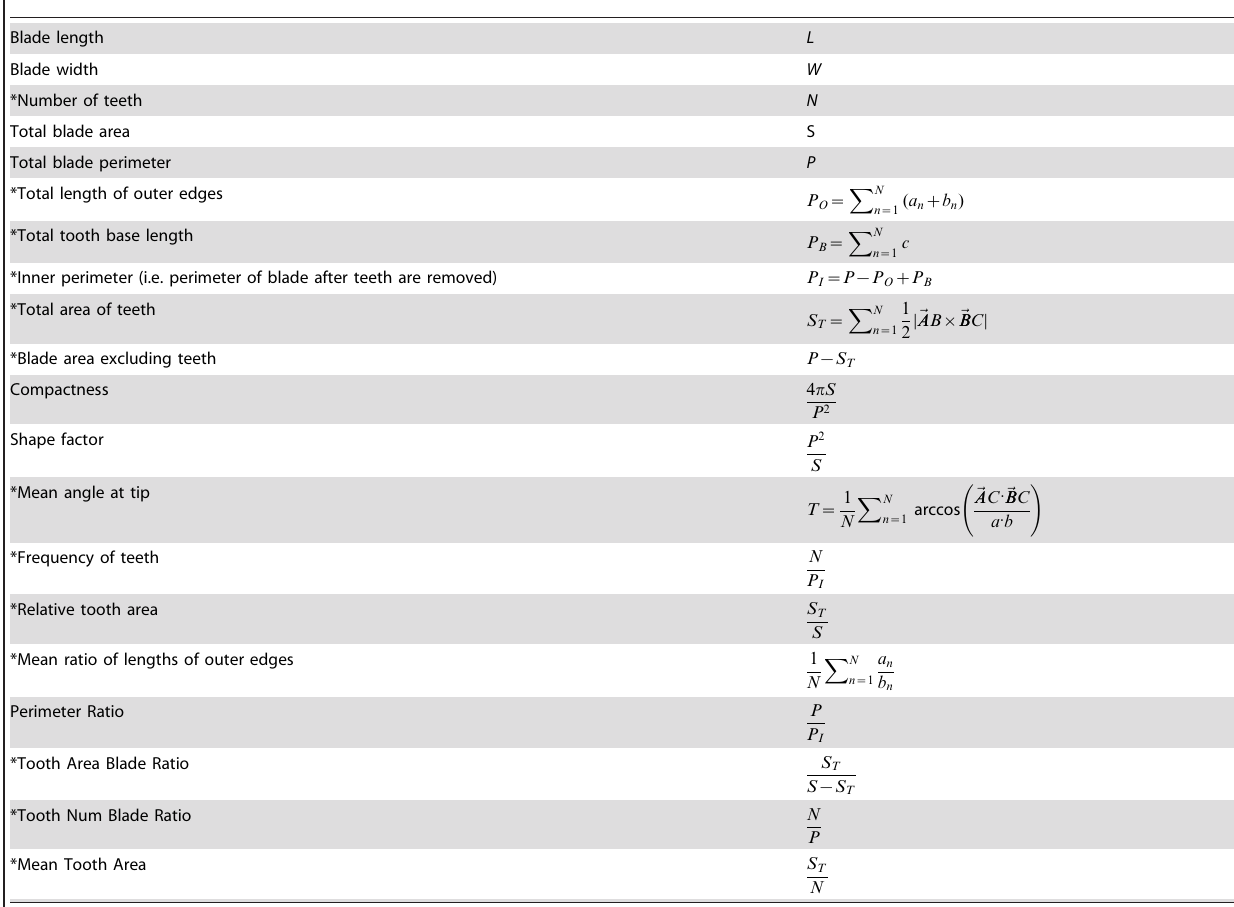
List of extracted features. The right-hand column gives the definitions in terms of the points A and B (the two sinuses) and C (the tooth tip), as in Figure 4, with a being the length of BC, b the length of AC and c the length of AB . The form P N n ~ 1 refers to summing a value across all the identified teeth. *Tooth-related characters. Features without a star relate to the blade but not specifically the teeth. Some of the experiments here distinguish between ‘‘tooth related’’ and ‘‘non-tooth related’’ characters.